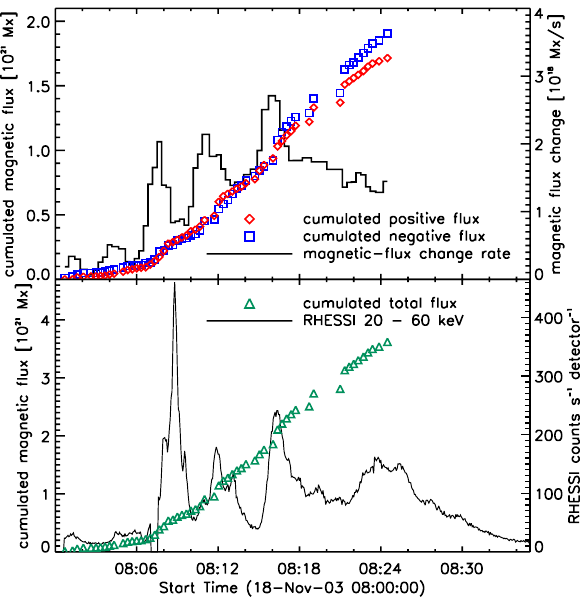
Fig. 7. Upper panel: Reconnection rate and cumulated positive and negative magnetic flux derived during the flare impulsive phase. Lower panel: Cumulated total magnetic flux and RHESSI 20– 60keV HXR time